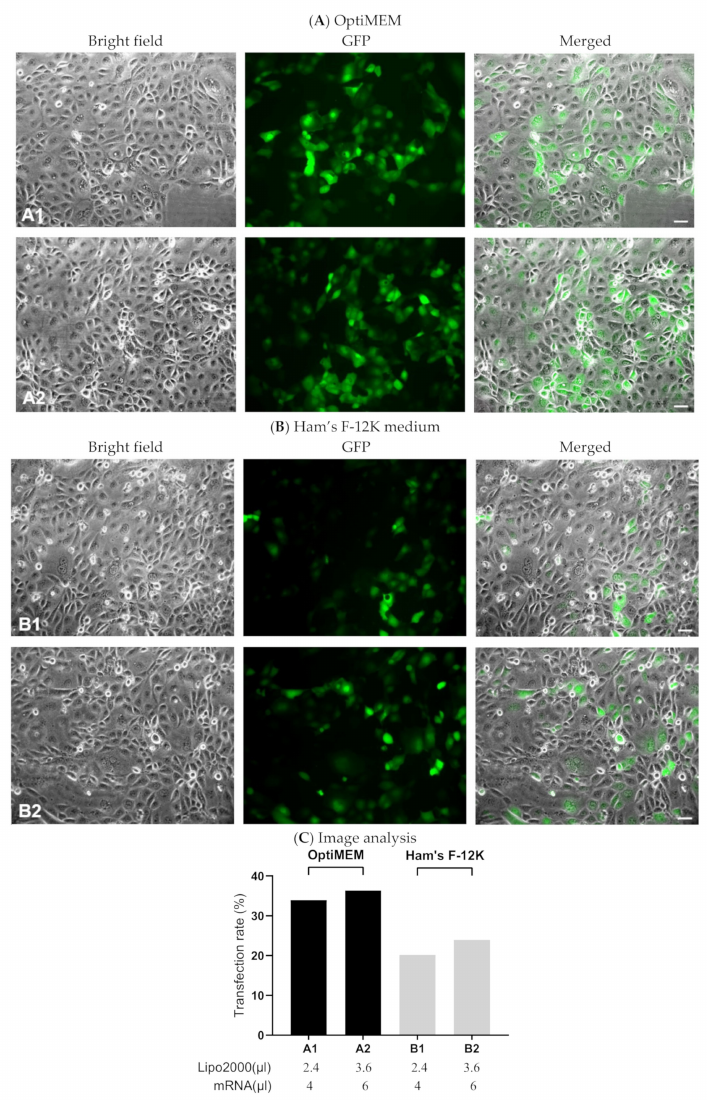
Figure 3. Transfection efficiency of GFP-mRNA on 16HBE cells. Totals of 2.4 µ L or 3.6 µ L Lipo- fectamine2000 were mixed, respectively, with 4 µ L or 6 µ L IVT-mRNA-encoding GFP (0.1 µ g/ µ L). Complexes were prepared in OptiMEM ( A ) or Ham’s F-12K medium ( B ). 16HBE cells were incubated with GFP-mRNA/Lipofectamine2000 complexes for 2 h. The pictures were taken 24 h after transfec- tion with an Axiovert fluorescence microscope. Scale bar: 40 µ m. ( C ) Quantitative analysis on the rates of successfully transfected cells in the images of ( A , B ). “Lipo2000” represents Lipofectamine2000 and “mRNA” represents